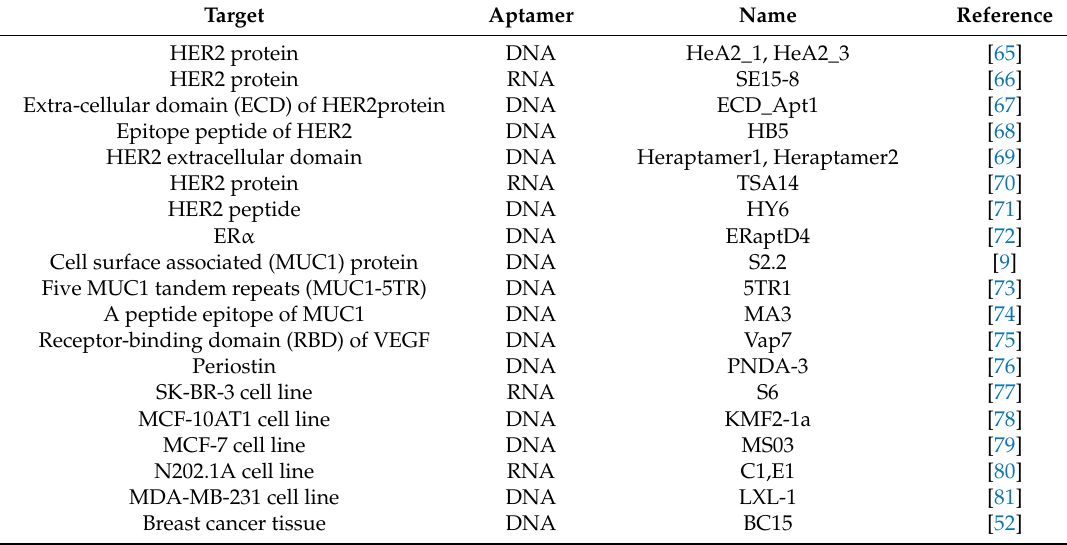
Table 2. Aptamers that have been identified to breast